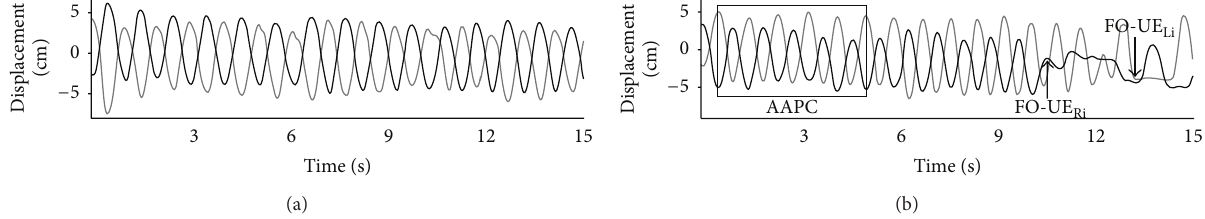
Figure 2: Kinematic trajectories (a) healthy older adult and (b) individual with PD-FOG with an FO-UE event. AAPC: average antiphase cycle; FO-UE Ri : initiation of right upper extremity freeze; FO-UE Li : initiation of left upper extremity